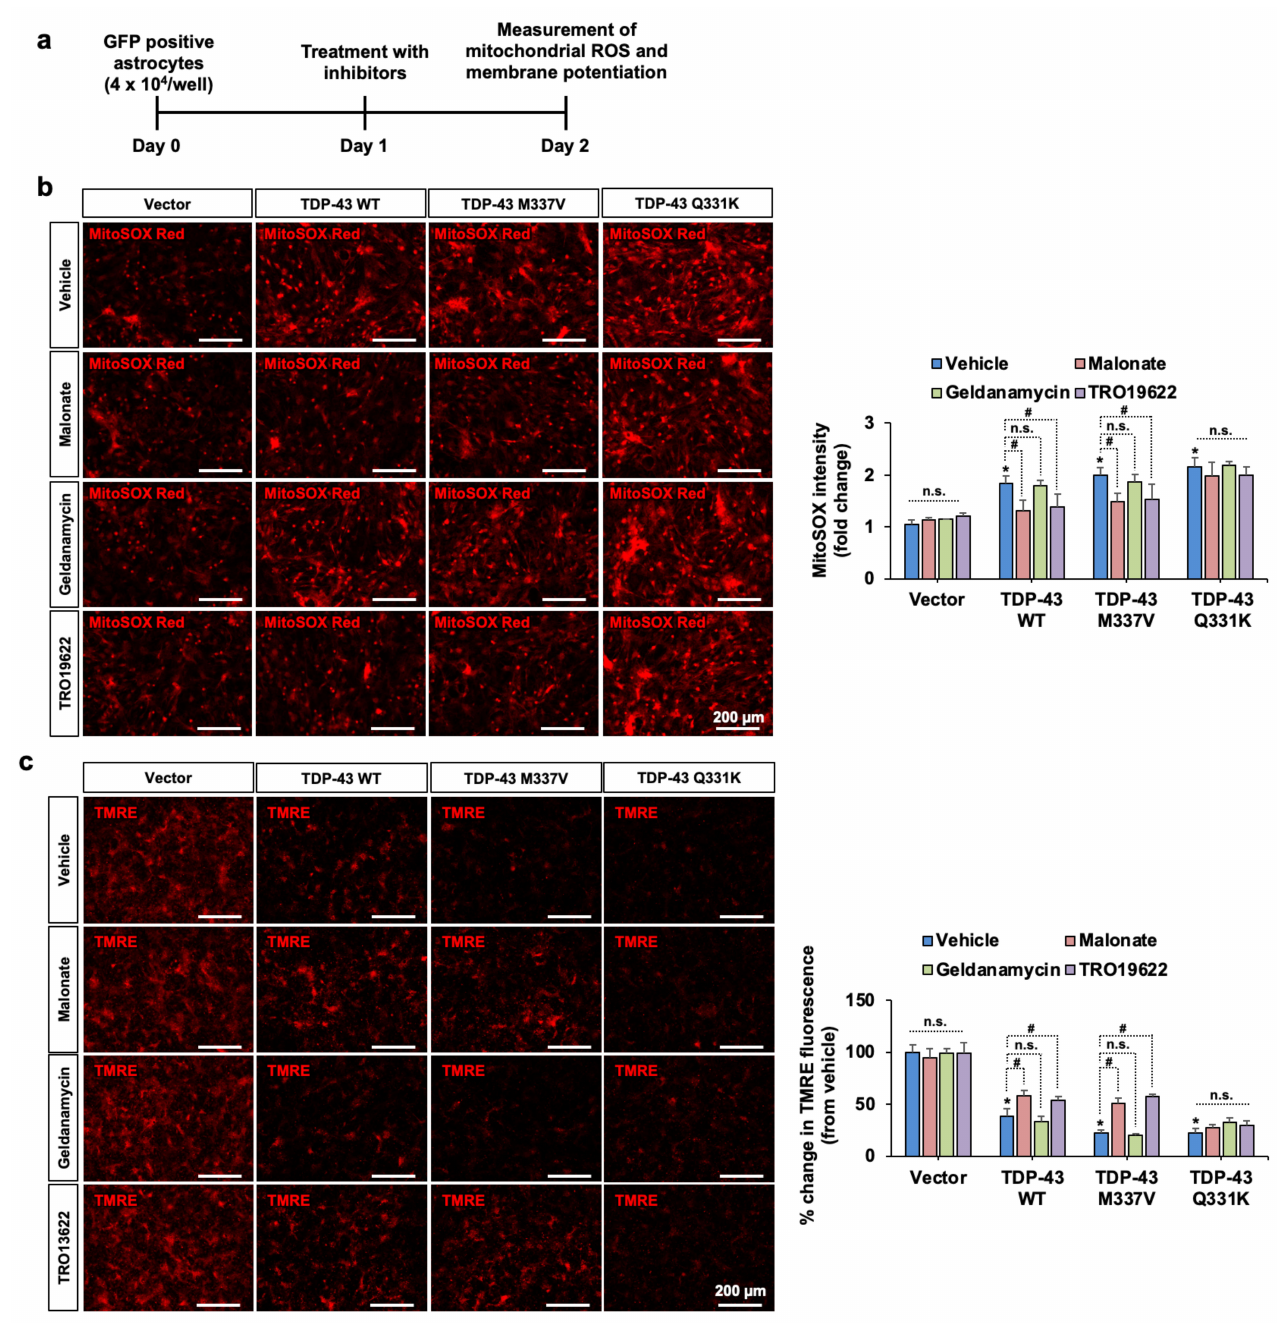
Figure 4. The effects of pharmacological inhibition of SDHA, VDAC3, and HSP90AB1 on TDP-43 WT and mutant-induced mitochondrial dysfunction in primary astrocytes. ( a ) Experimental timeline. ( b ) Mitochondrial reactive oxygen species (ROS) was measured by MitoSOX staining. The fluorescence intensity of MitoSOX is shown as fold change in the adjacent graph. ( c ) Astrocytic mitochondrial membrane potential was assessed by TMRE probing. Percent reduction in TMRE fluorescence is shown in the adjacent graph. Scale bars indicate 200 µ m. * p < 0.05 versus vehicle-treated control vector group; # p < 0.05 versus indicated groups; n.s., not significant. Data analysis by two-way ANOVA with four sister wells (biological replicates); mean ±